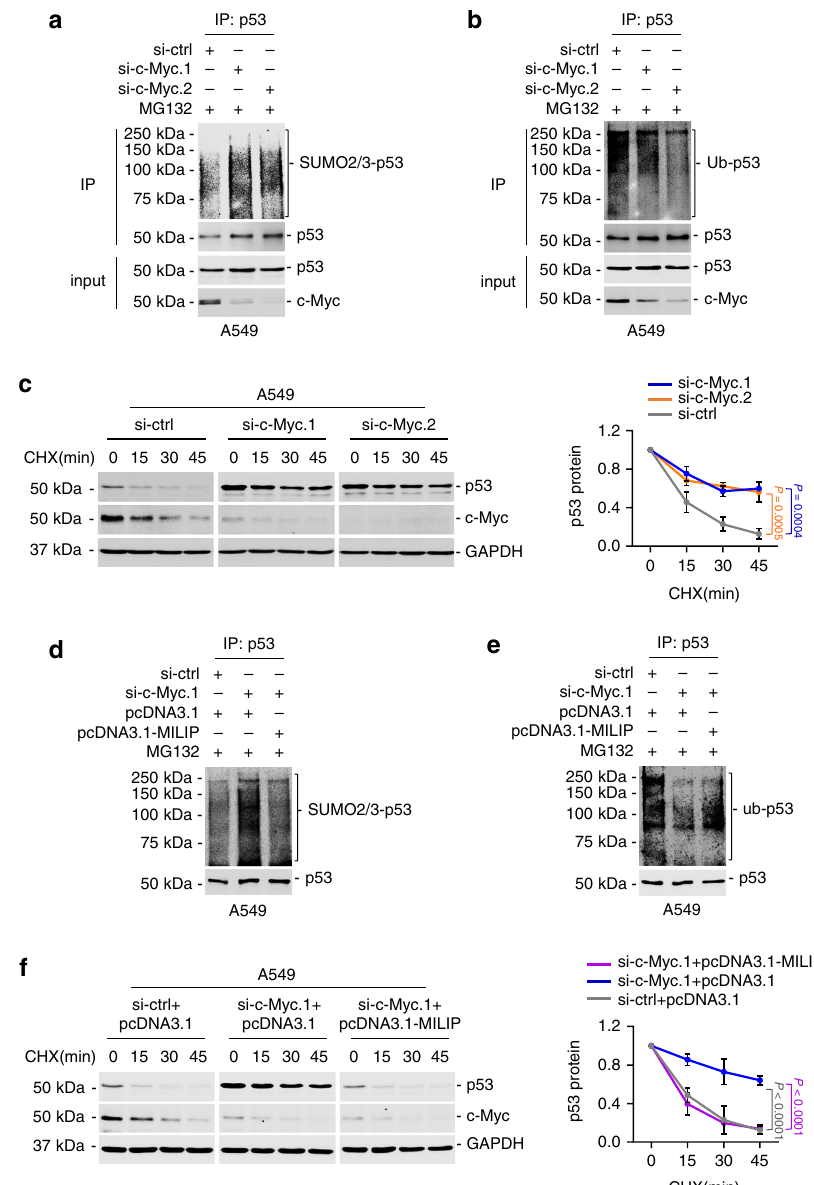
Fig. 5 c-Myc represses p53 through MILIP. a , d Knockdown of c-Myc increased modi fi cation of p53 by SUMO-2/3, which was reversed by overexpression of MILIP. Data shown represent three independent experiments. MG132: 10 µ M. b , e Knockdown of c-Myc decreased p53 polyubiquitination, which was reversed by overexpression of MILIP. Data shown represent three independent experiments. MG132: 10 µ M. c , f Knockdown of c-Myc prolonged the half- life time of p53 protein, which was reversed by overexpression of MILIP in CHX-chase assays. Data are representatives or mean ± s.d.; n = 3 independent experiments, one-way ANOVA followed by Tukey ’ s multiple comparisons test. CHX: 40 µ g/mL. Source data of Fig. 5a – f are provided as a Source Data fi le.